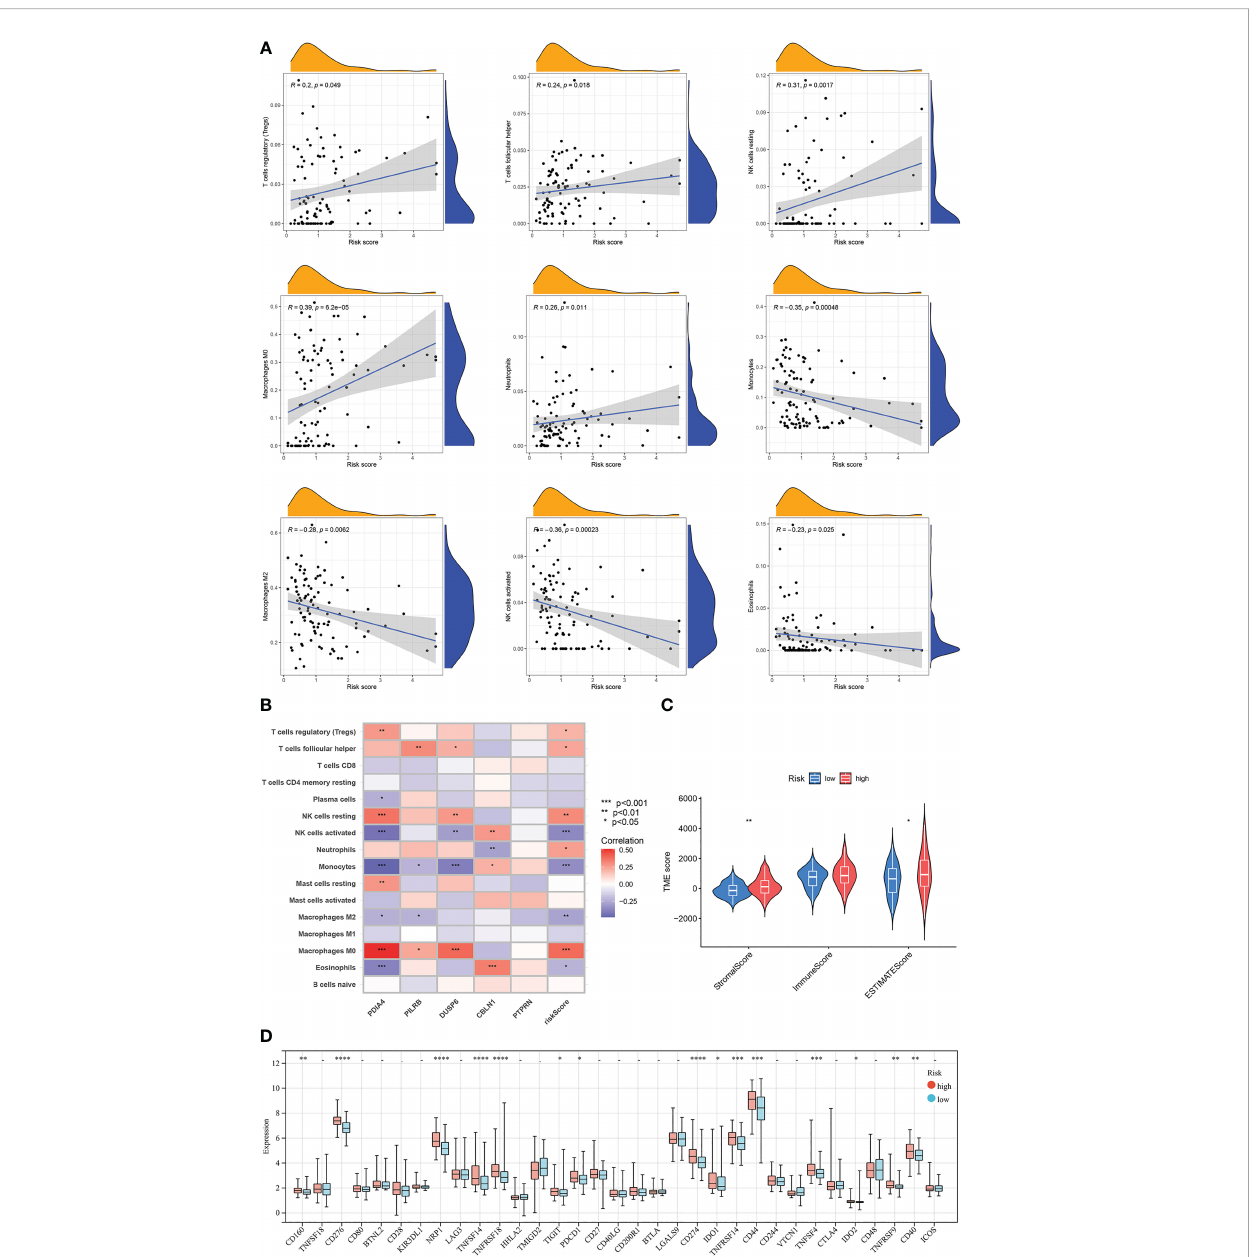
FIGURE 10 Evaluation of the TME and checkpoints between the two risk score groups. (A) Correlation analyses between risk scores and the contents of immune cells. (B) Correlation heatmap of Spearman correlation analyses between 5 model-related genes and the contents of immune cells. (C) The violin diagram shows the three kinds of TME scores in the high-risk group and low-risk group. (D) Differentially expressed analyses of immune checkpoints between the high-risk group and low-risk group. * p < 0.05, ** p < 0.01, *** p < 0.001, **** p < 0.0001, – p ≥ 0.05 vs. low-risk